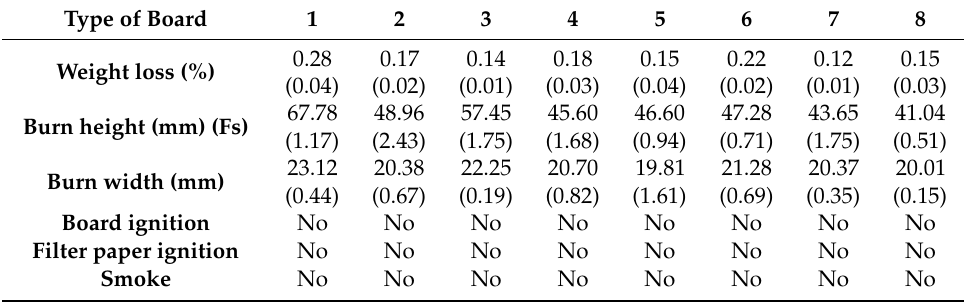
Table 7. Mean flame spread (Fs) results with respect to the type of